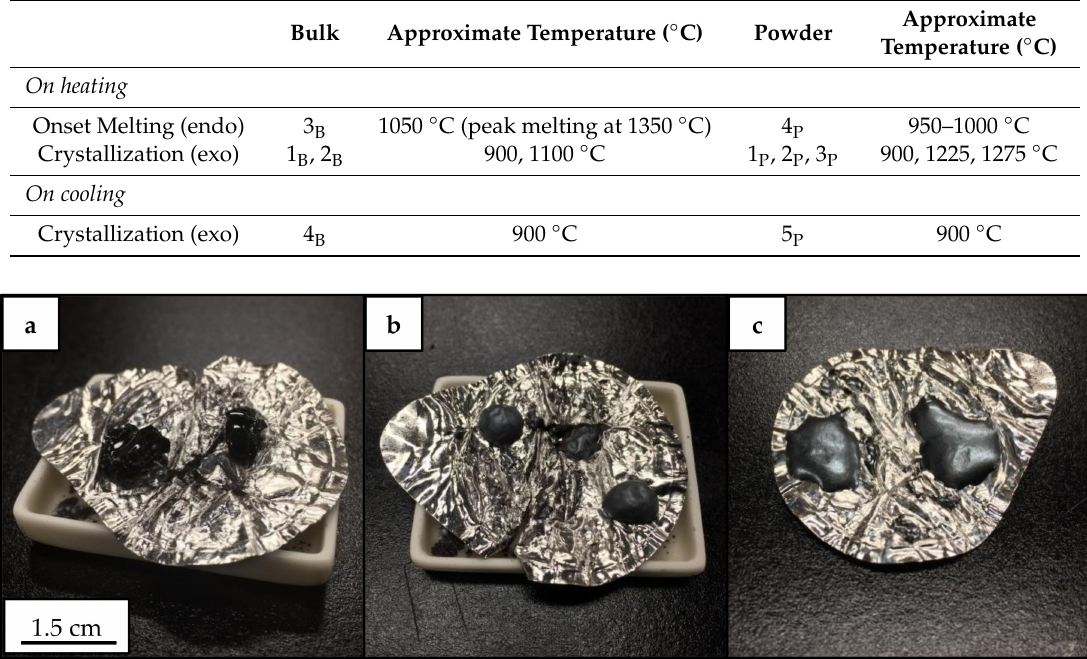
Figure 3. Bulk volcanic ash glass samples before heat treatment ( a ) and after heat treatment at 1100 ( b ) and 1150 ◦ C ( c ). The solidified glass samples are the dark droplets on Pt